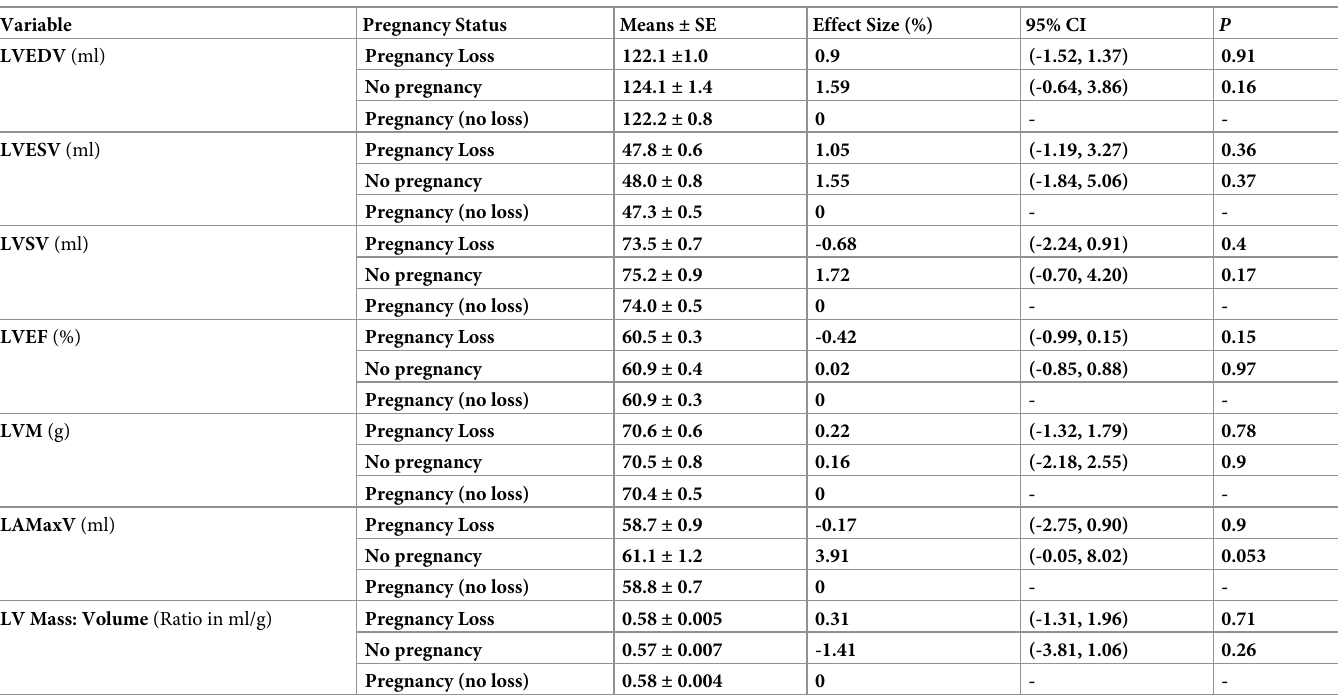
Table 3. CMR cardiac geometry adjusted for potential confounders.